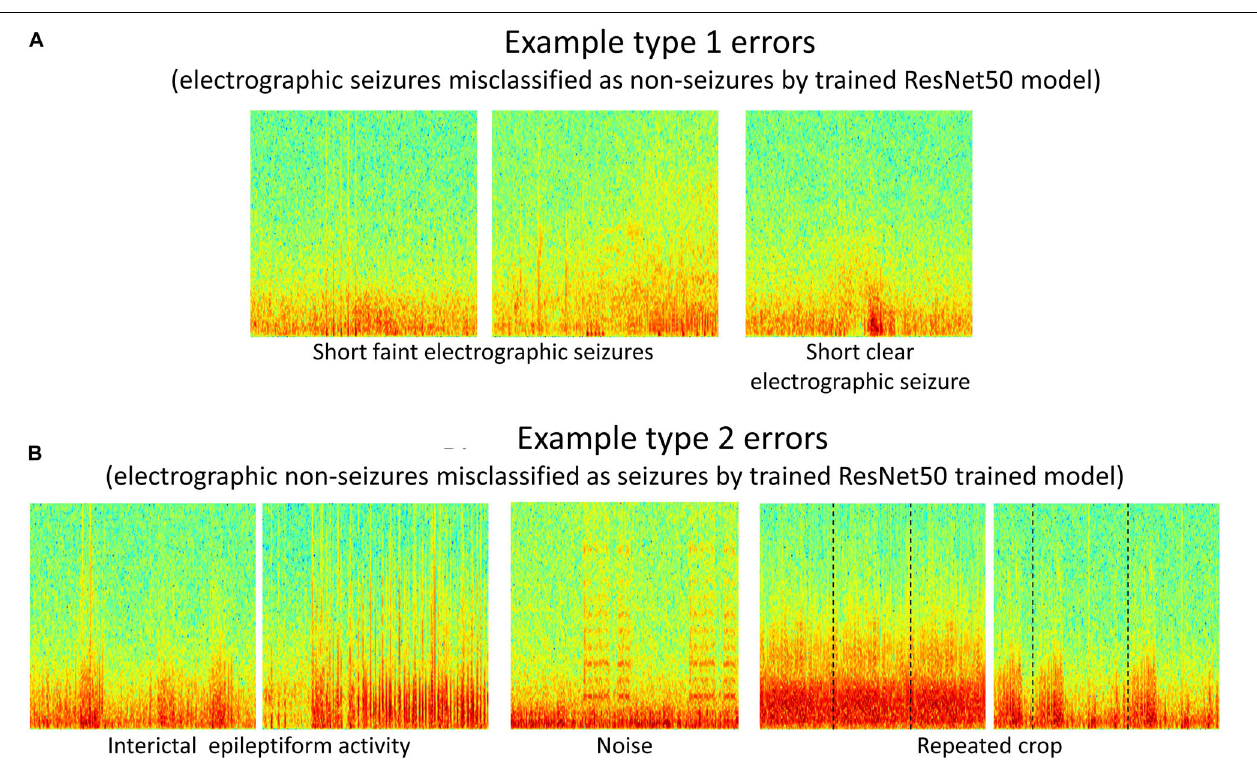
FIGURE 8 | (A,B) Example type 1 and type 2 errors by a trained ResNet50 model. Type 1 errors typically included short faint electrographic seizures, while type 2 errors typically included long trains of high amplitude interictal events, noise and repeated crops created during pre-processing electrocorticographic (ECoG) channels in cases where length was shorter than 80 s.